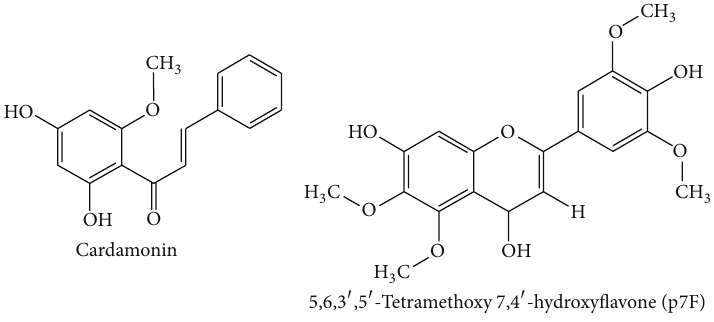
Figure 4: Chemical structures of Artemisia absinthium compounds.